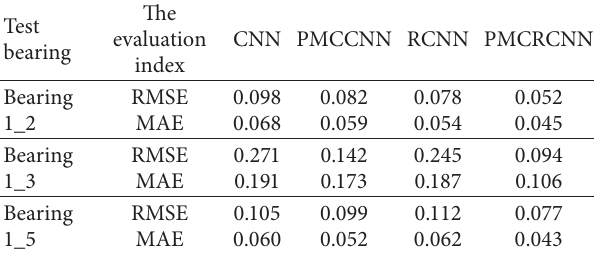
Figure 8: Performance estimate results of four different prognostics network. (a) RMSE values. (b) MAE values. Table 4: Prediction error of different